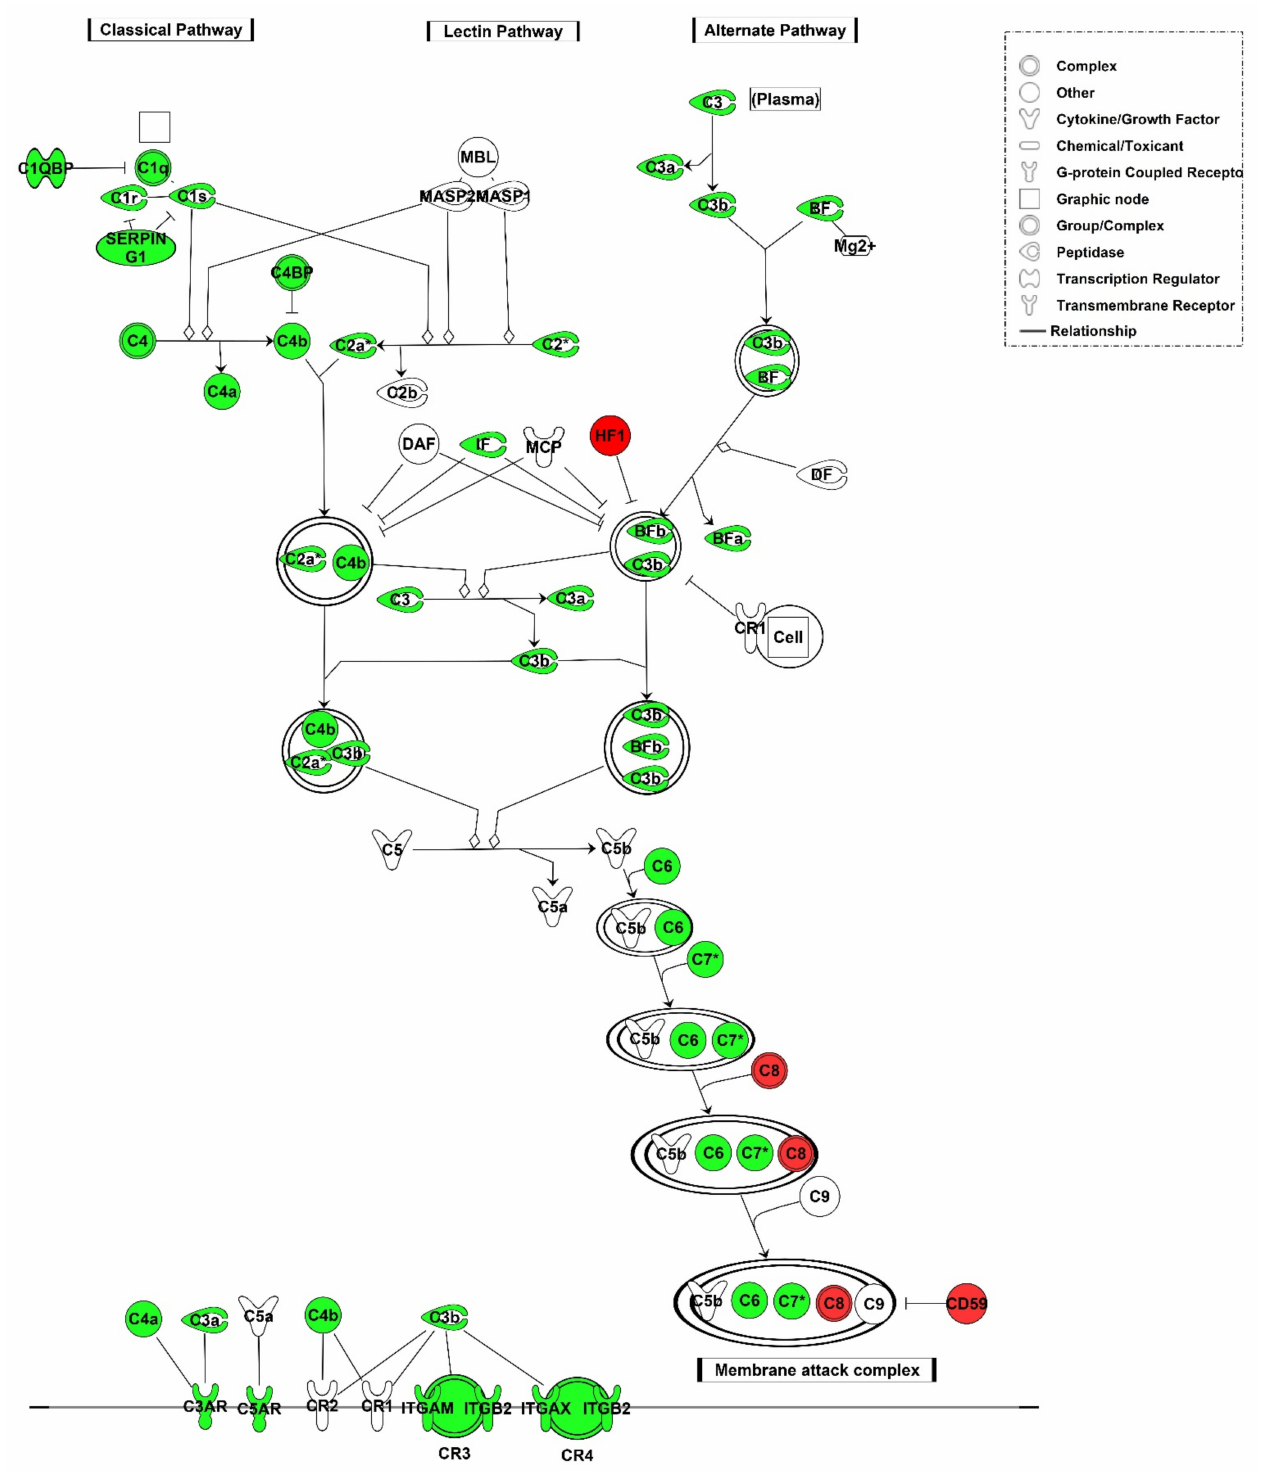
Figure 2. Complement pathway. Ingenuity Pathways Knowledge Base was used to display pathways containing multiple differently expressed genes. Significantly regulated genes after allogeneic transplantation with TCMR compared to syngeneic transplantation without rejection were mapped with the complement pathway. Upregulated genes are highlighted in green, downregulated genes are highlighted in